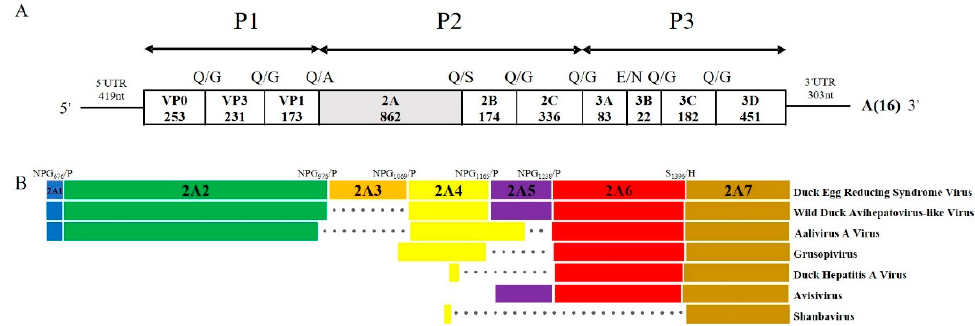
Figure 2. Schematic diagram of whole-genome and 2A region. ( A ) Predicted genome organization of the DERSV. P1 represents viral structural proteins, and P2 and P3 represent non-structural proteins. The length of amino acid was indicated in each gene box. ( B ) Comparison of putative 2A peptides of Picornaviruses. The dot represents the absence of amino acids and the different colors in the box represent 2A1(blue), 2A2(green), 2A3(orange), 2A4(yellow), 2A5(purple), 2A6(red), 2A7(golden).